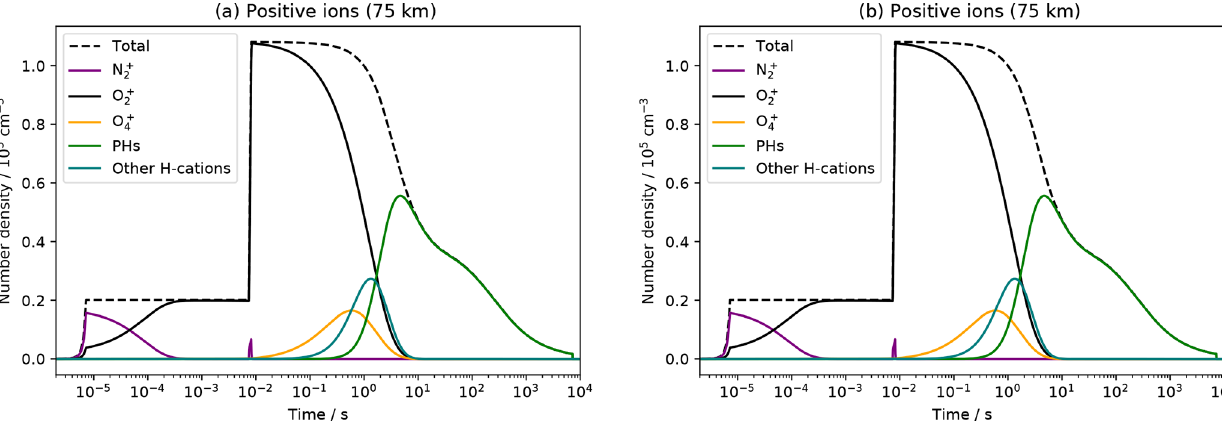
Figure 5. Simulated concentrations of the most abundant positive ions under the influence of the streamer electric fields for RUN1 as a function of time at (a) 75km and (b) 80km altitude. PHs denotes the sum of all modelled proton hydrates (H + ( H 2 O ) n = 1 ... 7 ). The teal solid line shows the sum of all hydrogen-containing positive ions except for proton hydrates.